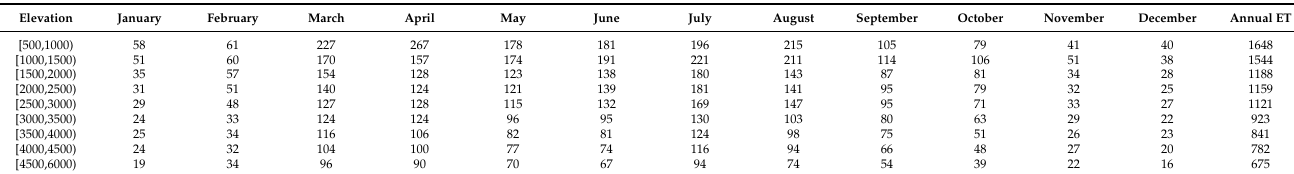
Table 1. Variation in ET with elevation